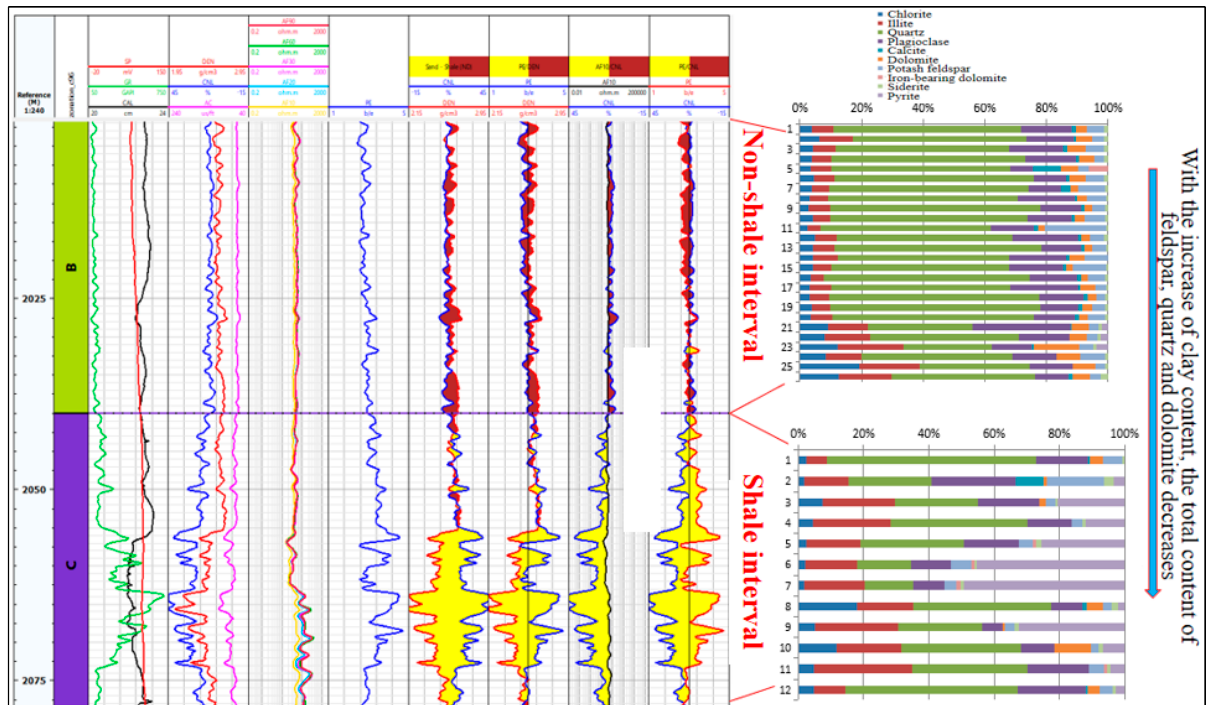
Figure 11. Well log curve and mineral content percentage diagram of Well J2.